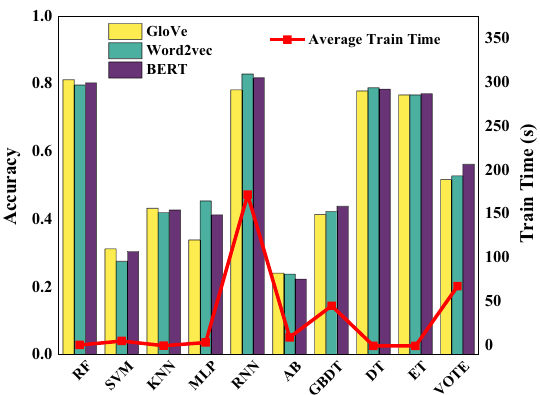
Fig. 9 The accuracy and average training time result from different combinations